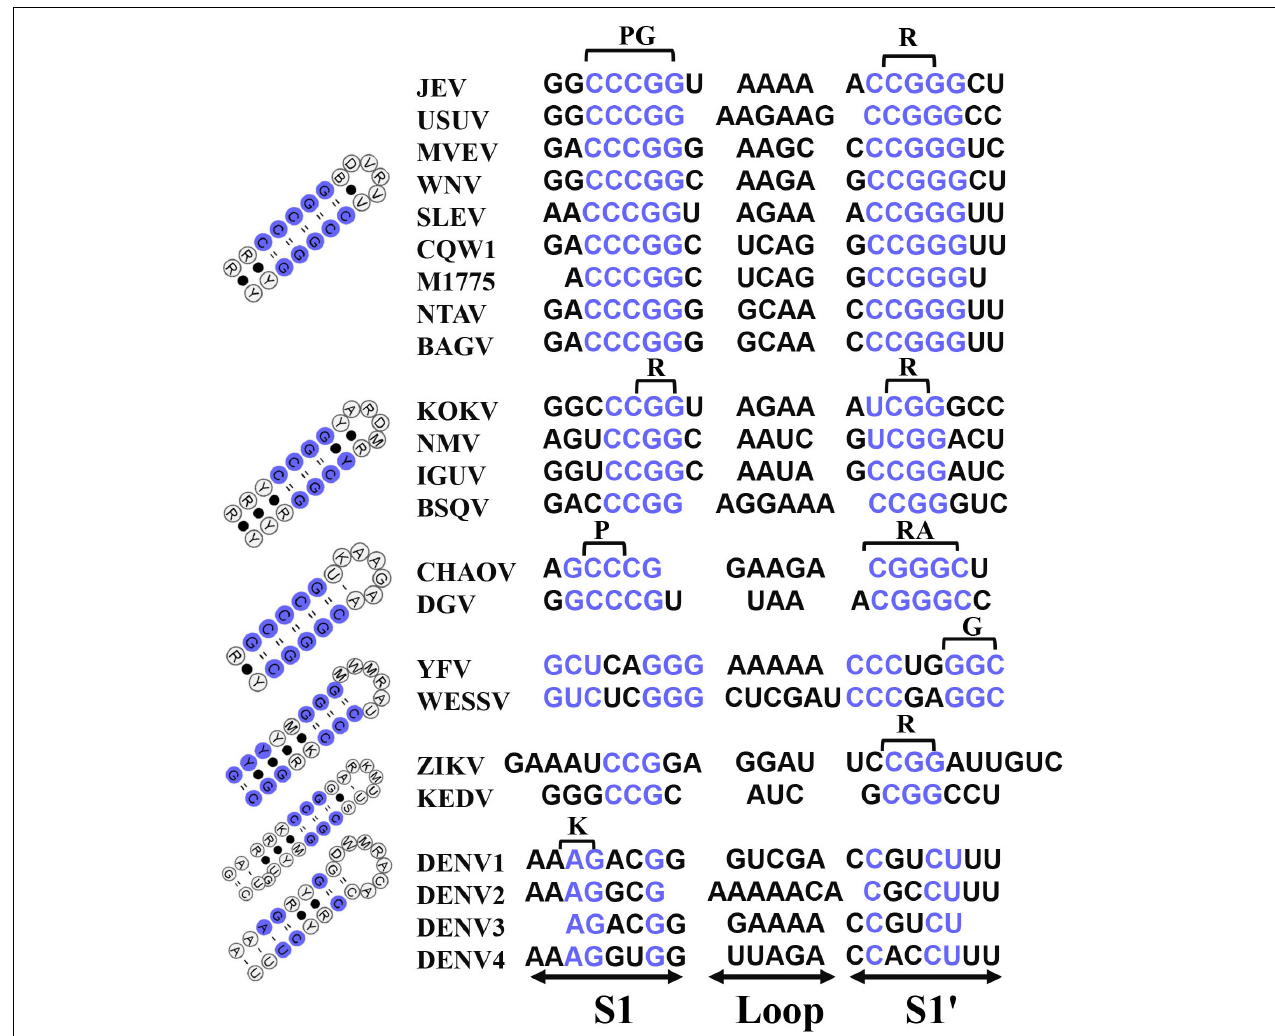
FIGURE 5 | Comparison of the homologous 5 (cid:48) cHP elements among MBFVGs. The nucleotide alignments of 5 (cid:48) cHP regions are in the left. The conserved nucleotides on the stem of each group are highlighted in blue. The abbreviations of amino acids determined by the conserved nucleotides are annotated. The 5 (cid:48) cHP models of the closely phylogenetically related MBFVGs are in the left. The commonly used merger base codes were used for construction of the consensus mode (M = A,C; R = A,G; W = A,T; S = G,C; Y = C,T; K = G,T; V = A,G,C; H = A,C,T; D = A,G,T; B = G,C,T; N =